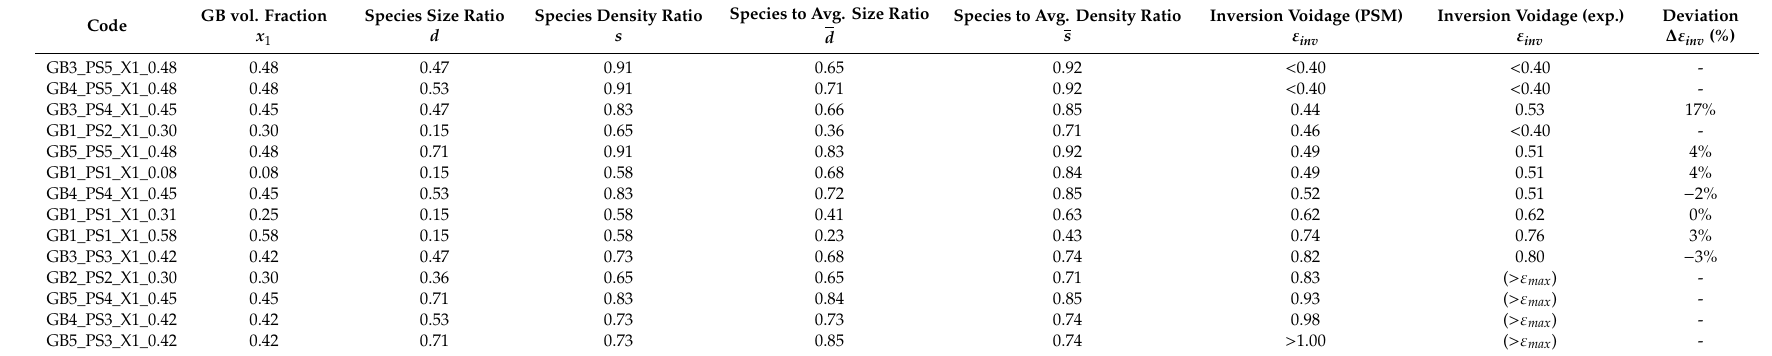
Table 3. Combinations of solids and mixture properties of the investigated systems, with composition, absolute species and species-to-average size and density ratios, inversion voidage predicted by Equation (9) or Equation (12) (Particle Segregation Model, PSM), the experimentally determined inversion voidage and the deviation between the last